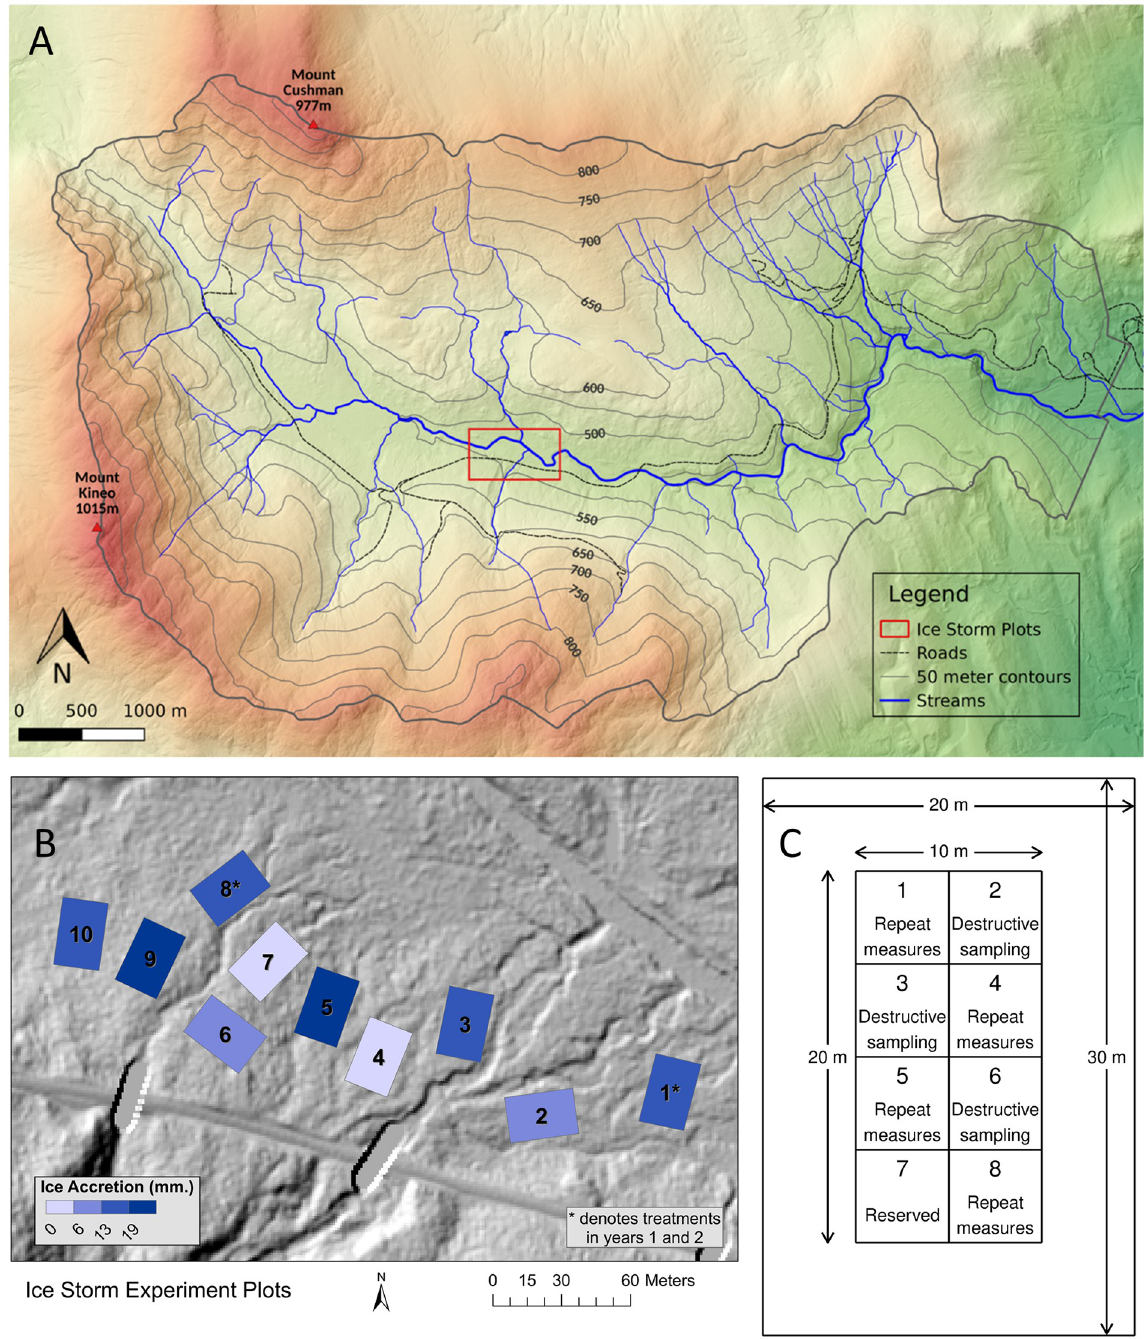
Fig 1. Ice plots location and layout. (A) Experiment location within the Hubbard Brook Experimental Forest. (B) Ice plot location between the Hubbard Brook (top right) and the Hubbard Brook Experimental Forest access road (bottom). Plots 1–5 are in Block 1 and plots 6–10 are in Block 2. Asterisk indicates plots that were iced in both 2016 and 2017. (C) Individual ice plot design, showing the entire plot (20 x 30 m), the inner plot (10 x 20 m), and subplots (5x5 m) for destructive and non-destructive measurements.